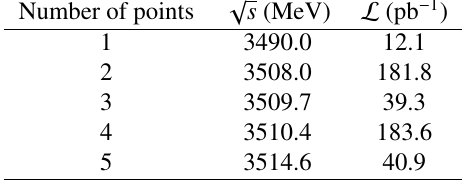
p s ) and integrated luminosity ( L ) of the data